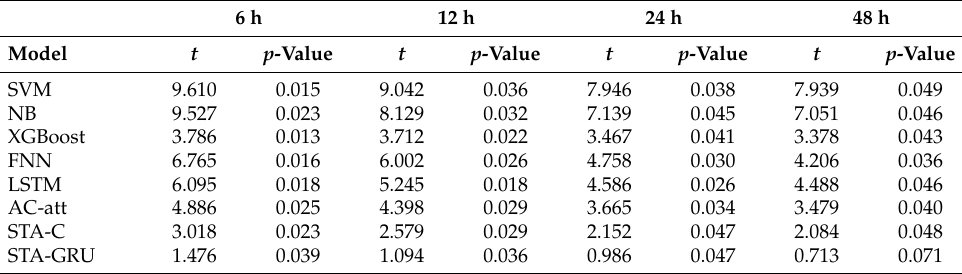
Table 4. t -test for comparing our classification model with baselines for 6h, 12h, 24h, and 48h forecasts. 6